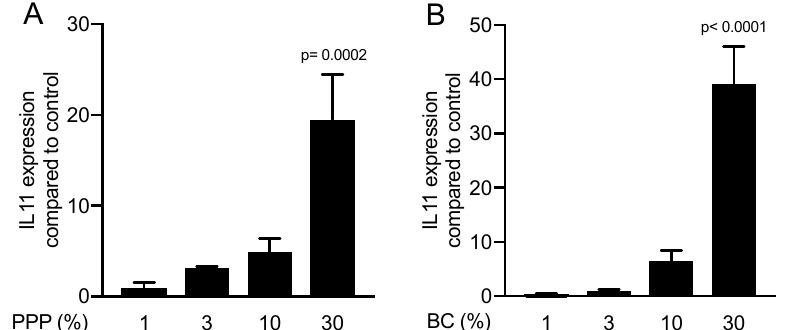
Figure 2. The e ff ect of PPP and bu ff y coat is dose-dependent. Gene expression analysis for IL11 in gingival fibroblasts incubated with di ff erent concentrations of ( A ) PPP and ( B ) bu ff y coat (N = 3). Data are presented as mean ± SD.